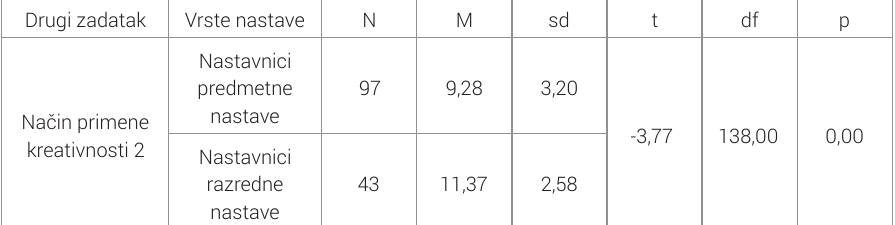
Table 6/ how to apply creativity